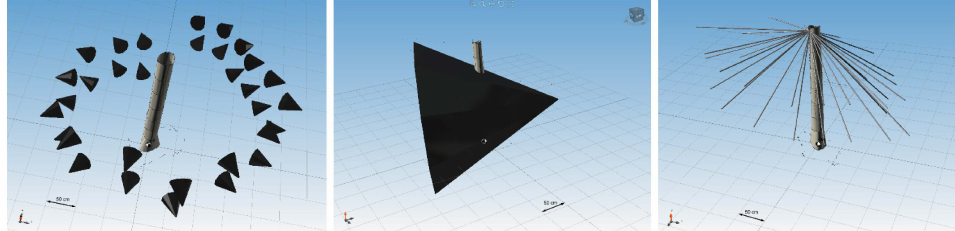
Figure 5. Left : the positions of individual cameras with their rotations and field of view, middle : the angle of view of one camera, right : the connections of point to all cameras for determination of